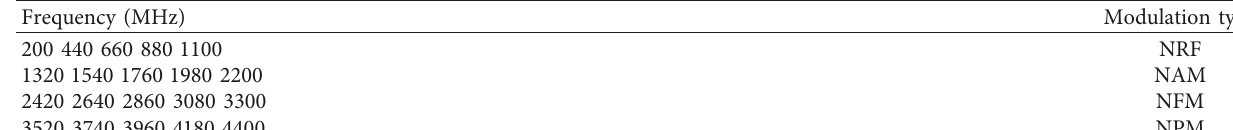
Table 3: Simulation parameters for jamming signal.